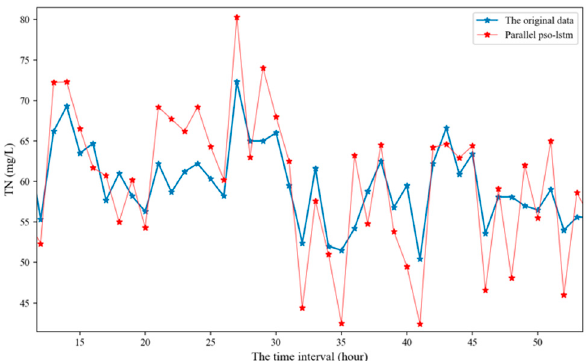
Figure 8. The prediction of total nitrogen (TN) time series using parallel PSO-LSTM model for 40 moments in time.